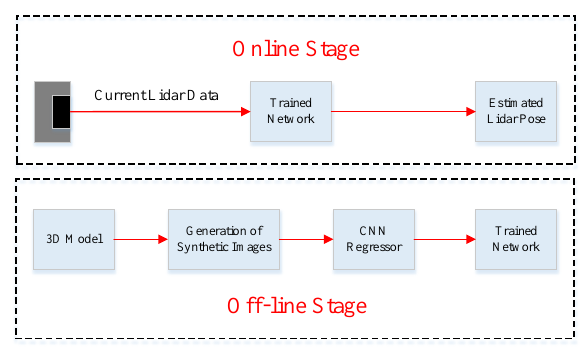
Figure 1. Workflow of our relocalization